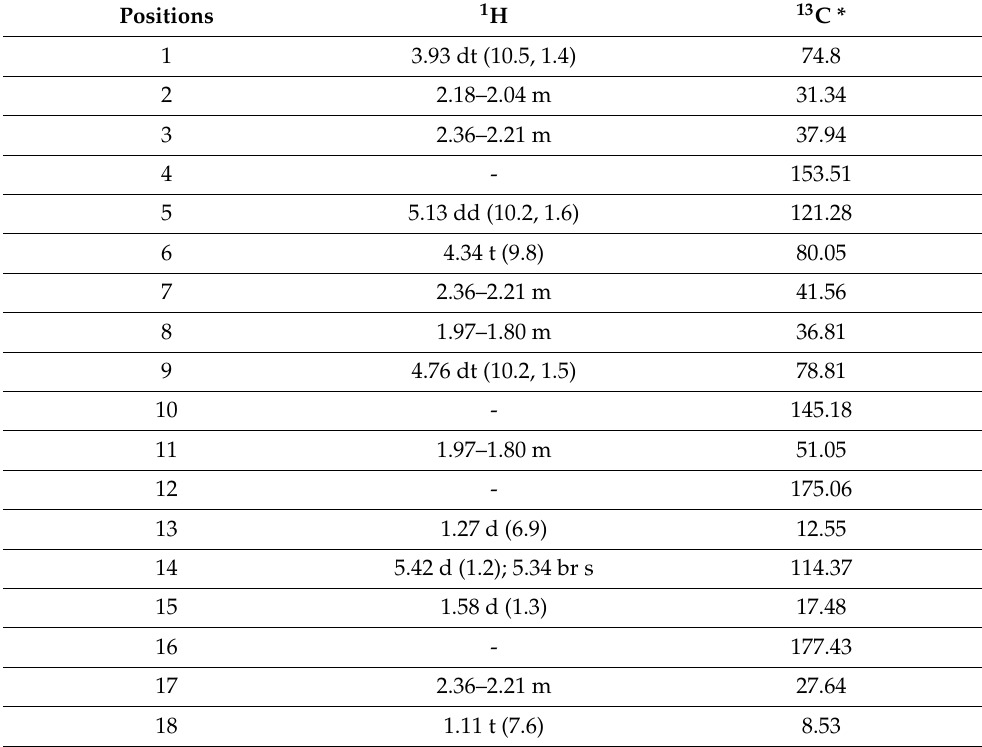
Table 1. NMR Data for 11 (500 MHz for 1 H and 125 MHz for 13 C, in CDCl 3 , δ in ppm, J in Hz). Positions